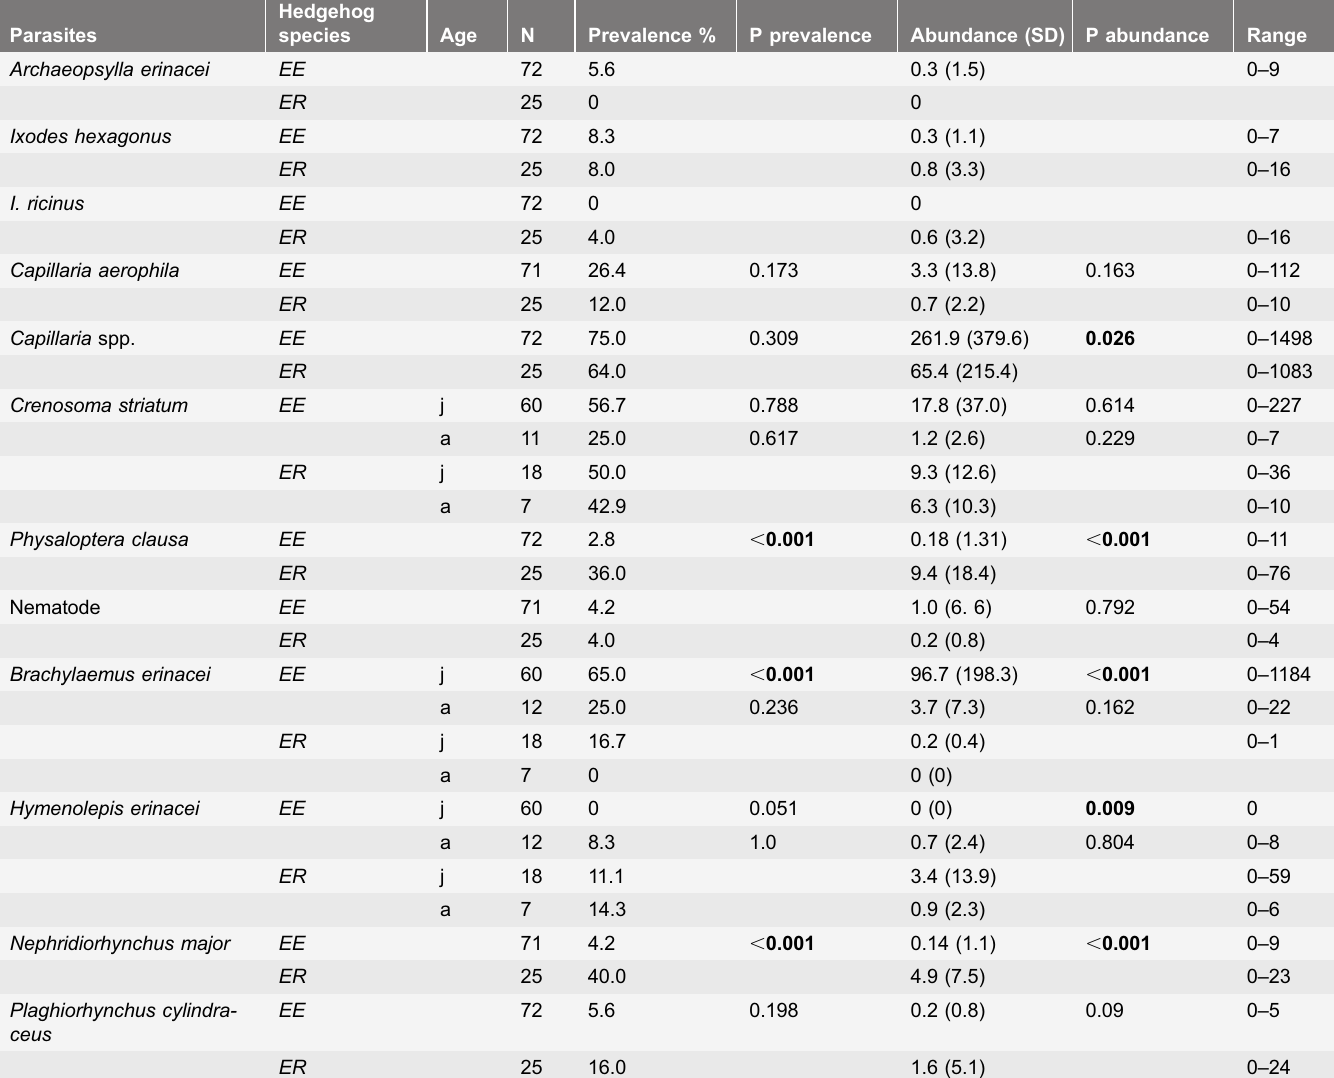
Hedgehogs from different sexes and ages are pooled, except for Crenosoma striatum , Brachylaemus erinacei and Hymenolepis erinacei for which age groups were treated separately; EE 5 Erinaceus europaeus , ER 5 Erinaceus roumanicus , j 5 juvenile, a 5 adult, N 5 number of samples, SD 5 standard deviation, hoglets (N 5 8) are not represented in the table. Note: developmental stages of ticks were pooled. P 5 probability based on x 2 -test for differences in prevalence and Mann-Whitney U-test for differences in abundance, p-values represent the differences between the two hedgehog species, ecotparasite prevalence and abundance were not statistically analyzed, because the sampling method might lead to